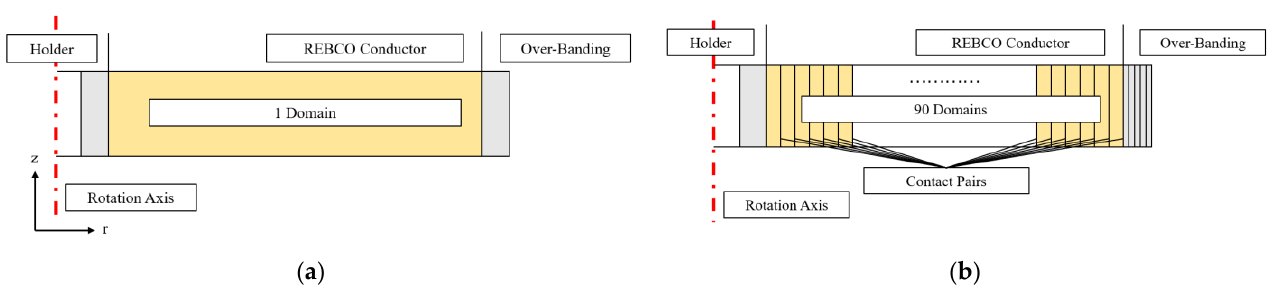
Figure 2. The schematic diagrams of two mechanical models (for Coil 2). ( a ) The bulk model. ( b ) The discrete contact